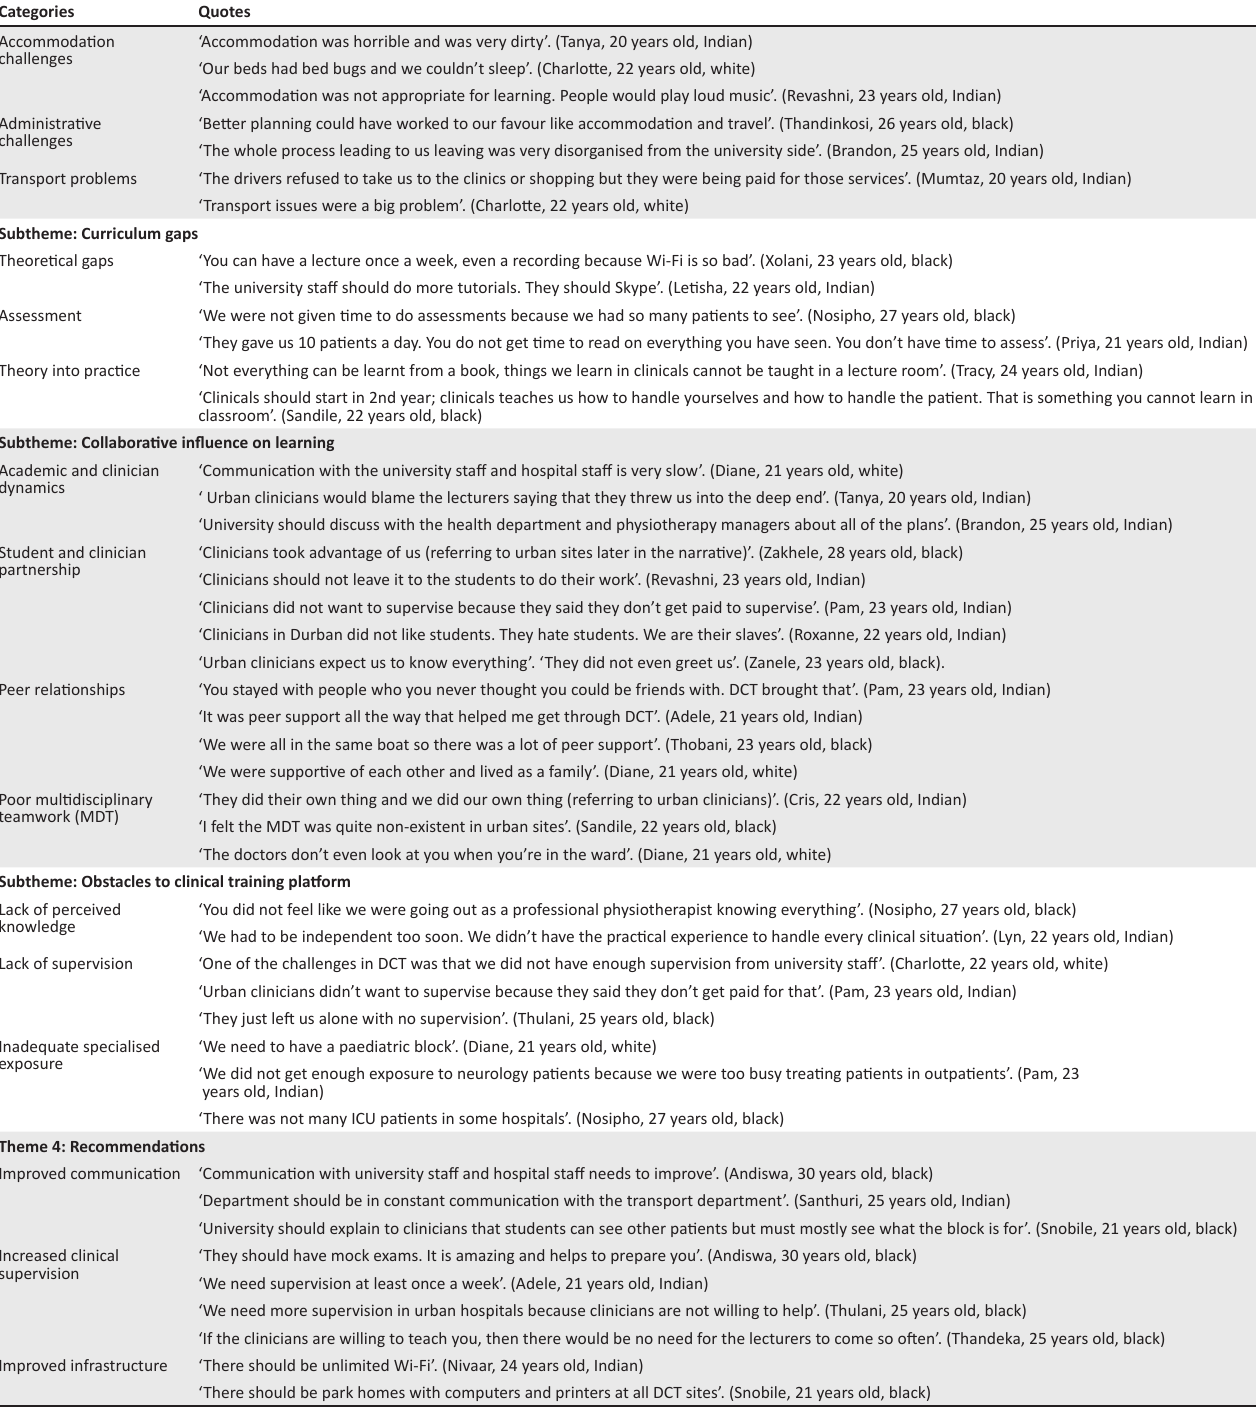
TABLE 1 (Continues...): Themes, subthemes, categories and illustrative